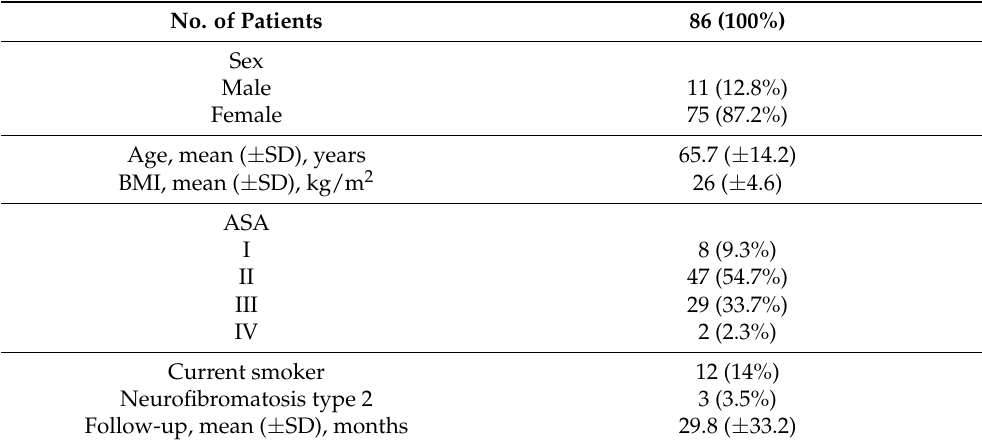
Table 1. Patient characteristics. No. of